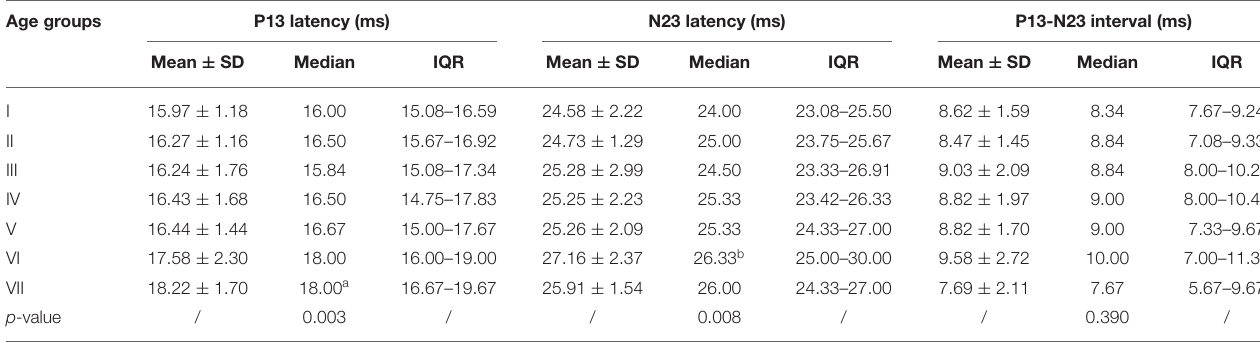
TABLE 2 | The latencies and P13-N23 interval of B81-cVEMP with increasing age. Age